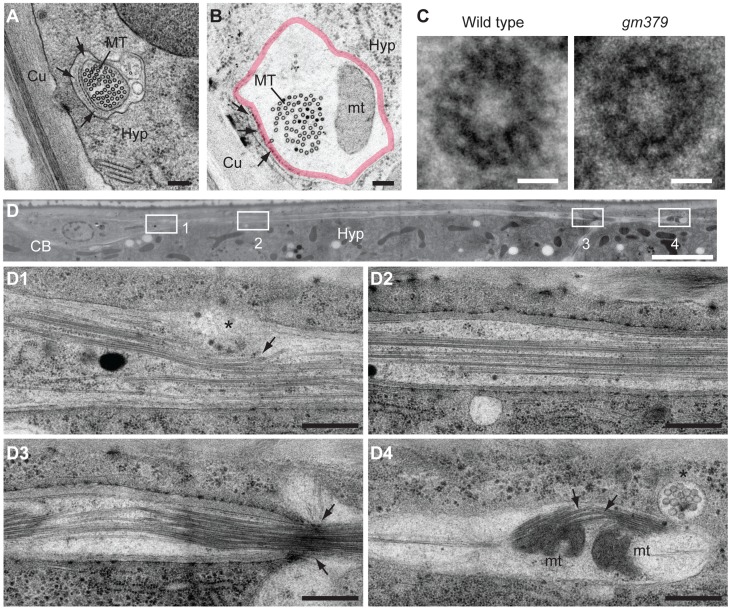
Ultrastructural characterization of neuronal defects of the gm379 mutant.(A-C) Transverse EM sections showing the ultrastructure of touch neurons in the wild type (A and C, left panel) and in the mutant (B and C, right panel). (A, B) Microtubule numbers within the touch neuron process were preserved in the mutant. However, a mitochondrion (mt) was located eccentrically, resulting in a marked increase in focal axon diameter (marked by the thick red line). The extracellular matrix (arrows) that normally surrounds the touch neuron process seemed to break at axon swelling sites. Scale bar  = 150 nm. (C) Individual microtubule polymers from the wild type (left) and the mutant (right) both contained 15 protofilaments. The intraluminal electron-dense materials in the microtubule were also preserved in the mutant. Scale bar  = 10 nm. (D) Longitudinal EM section of an ALM neuron in the adult mutant, with anterior to the right. Scale bar  = 5 µm. (D1) Microtubule bundles were compressed (arrow) by some organelles of uncertain identity (asterisk) at the proximal axon segment. (D2) Microtubule polymers assumed straight, more wild-type appearance at certain regions of the axon. (D3) Microtubules were compressed and strangled at focal axon constriction (arrow), which profoundly distorted the axonal cytoskeleton. (D4) Focal mitochondrial accumulation (mt) distorted microtubule bundles (arrows), the latter assuming a curved configuration that was never seen in the wild-type axon. A small protrusion (asterisk) from the axonal membrane contained small membrane-bound profiles of unknown identity. Scale bars  = 0.5 µm. CB, cell body of ALM; Cu, cuticle; Hyp, hypodermal cell; MT, microtubules.